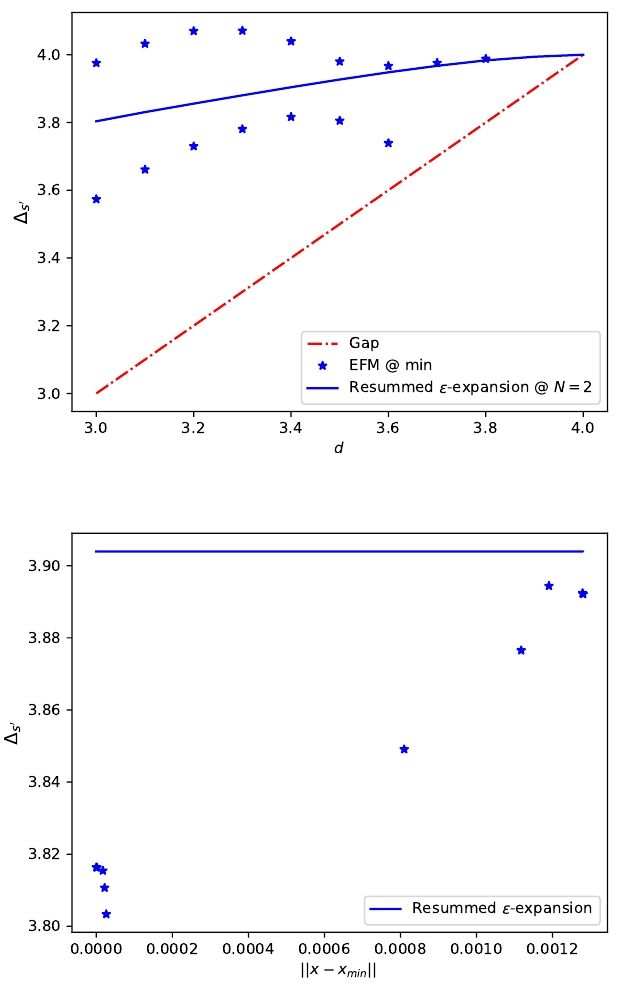
Figure 7: Top: Jump in subleading operator s (cid:48) in the (cid:96) = 0 S channel found by the EFM at the navigator minimum for N = 2. Bottom: Evolution of s (cid:48) extracted from different points along the BFGS run for ( d = 3.4, N = 2 ) , as functions of their distance to the transformed navigator